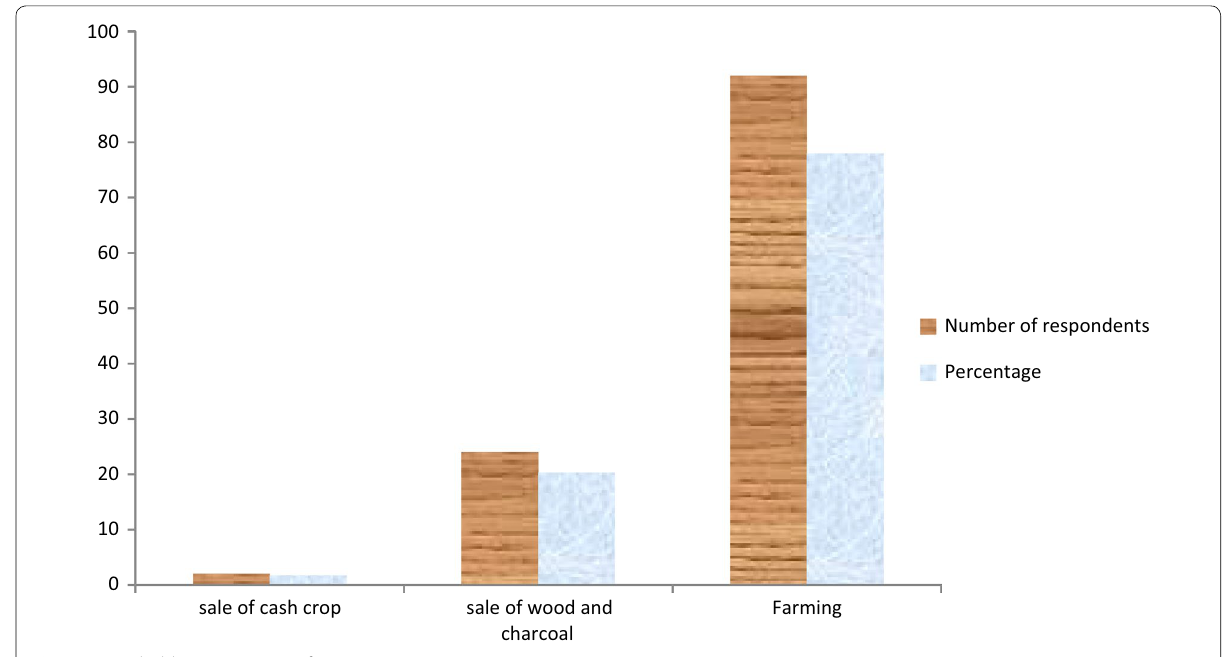
Fig. 6 Households major source of income